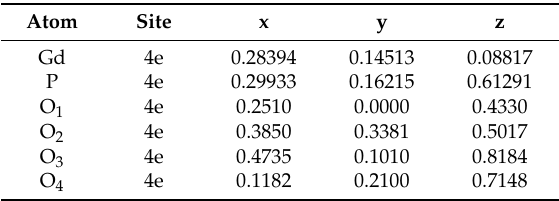
Table 2. Atomic positions of monazite-type GdPO 4 at 0 GPa.